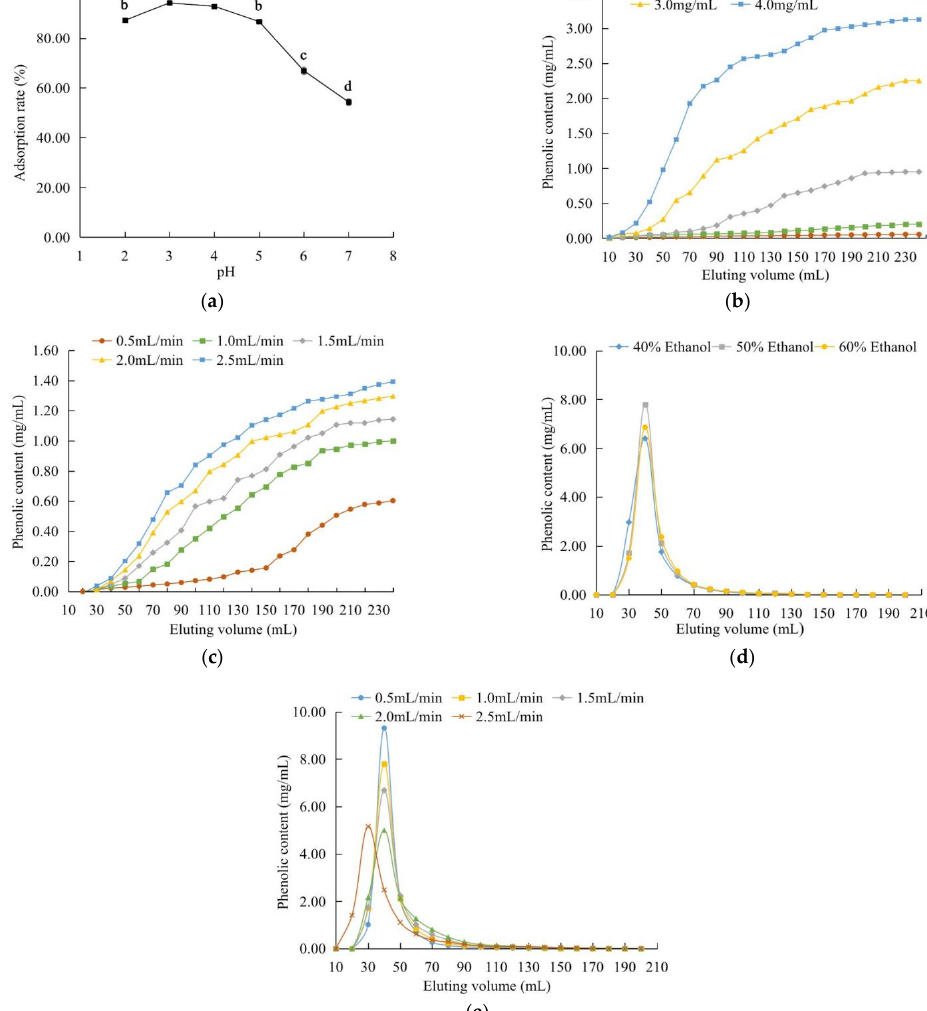
Figure 3. Effects of the different variables on the adsorption and desorption properties of LSA-900C: ( a ) the pH of the crude extract solution; ( b ) the mass concentration of the crude extract solution; ( c ) the flow rates of the crude extract solution; ( d ) the concentration of ethanol in the eluent; ( e ) the flow rate for the elution. Different letters indicate significant differences ( p < 0.05)